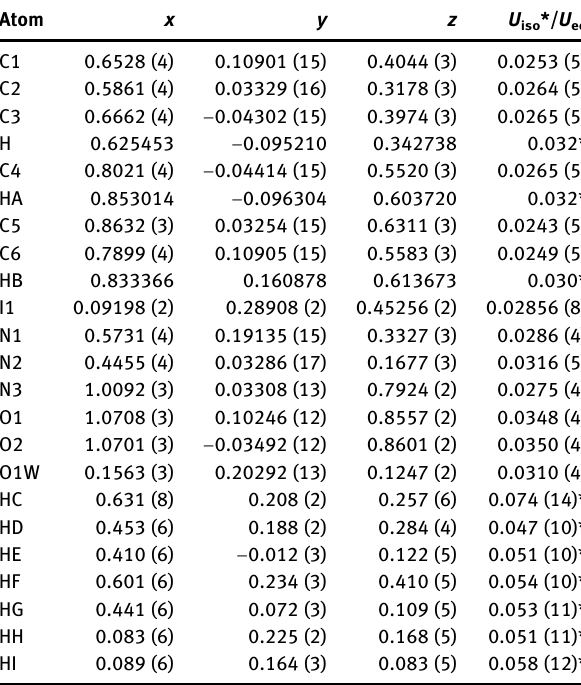
Table  : Fractional atomic coordinates and isotropic or equivalent isotropic displacement parameters (Å 